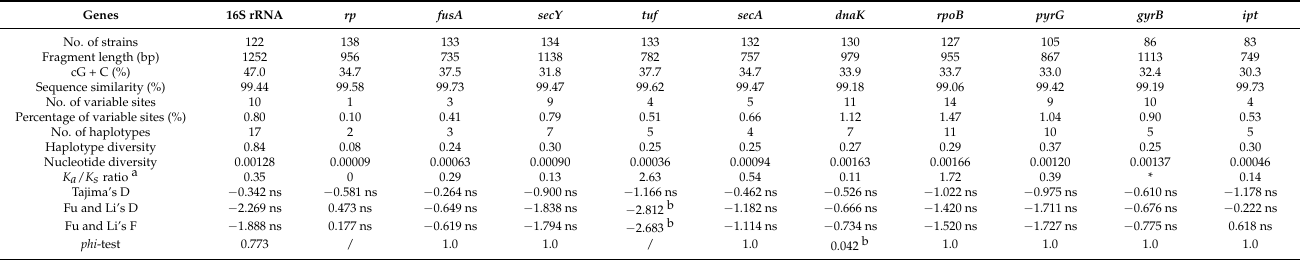
Table 2. Genetic parameters calculated for 16S rRNA and each housekeeping gene sequences of PaWB phytoplasma strains by MLST